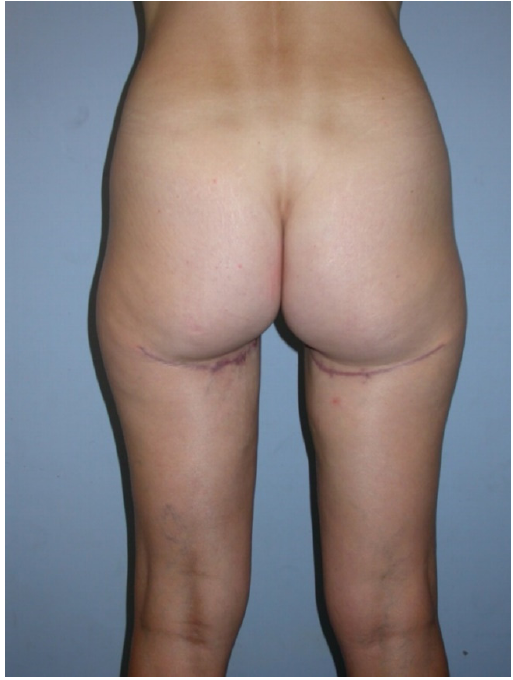
Figure 11. Post-operative caudal scar migration.